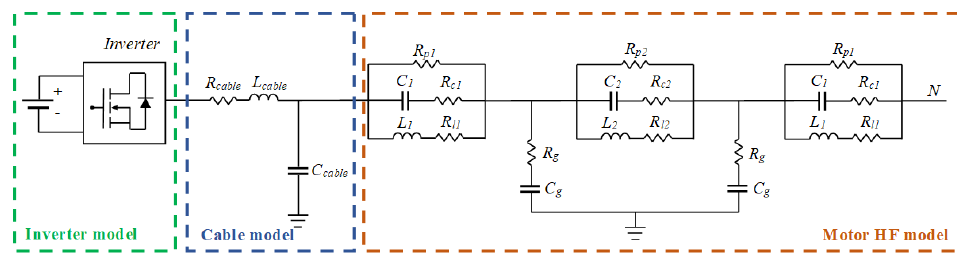
Figure 20. Per phase HF equivalent circuit of the inverter-cable-motor